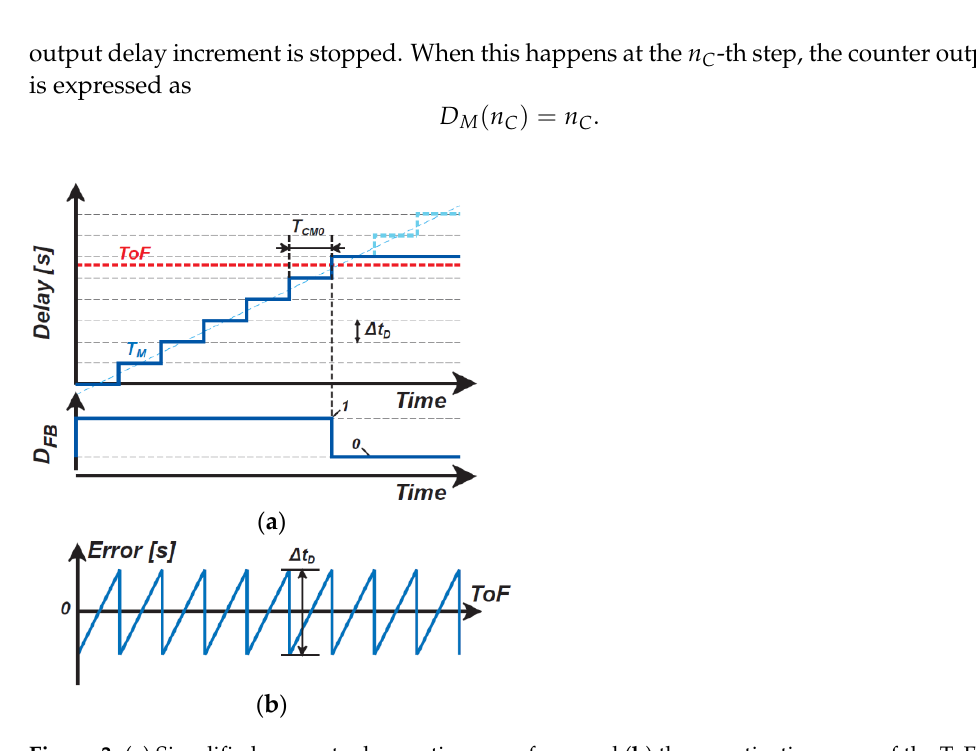
Figure 3. ( a ) Simplified conceptual operating waveform and ( b ) the quantization error of the ToF for coarse measurements.